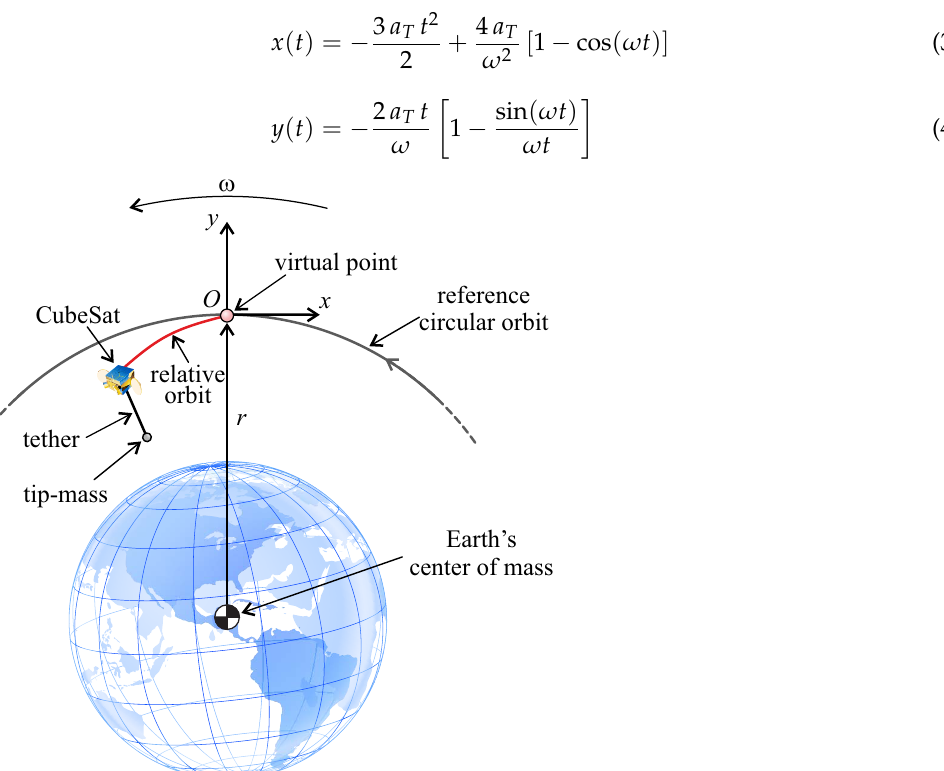
Figure 3. Rotating reference system T ( O ; x , y ) and relative trajectory (solid line) of a PB-based CubeSat. Note that the conditions x ( 0 ) = y ( 0 ) = 0 indicate that the virtual point O coincides with the CubeSat center of mass at initial time t =